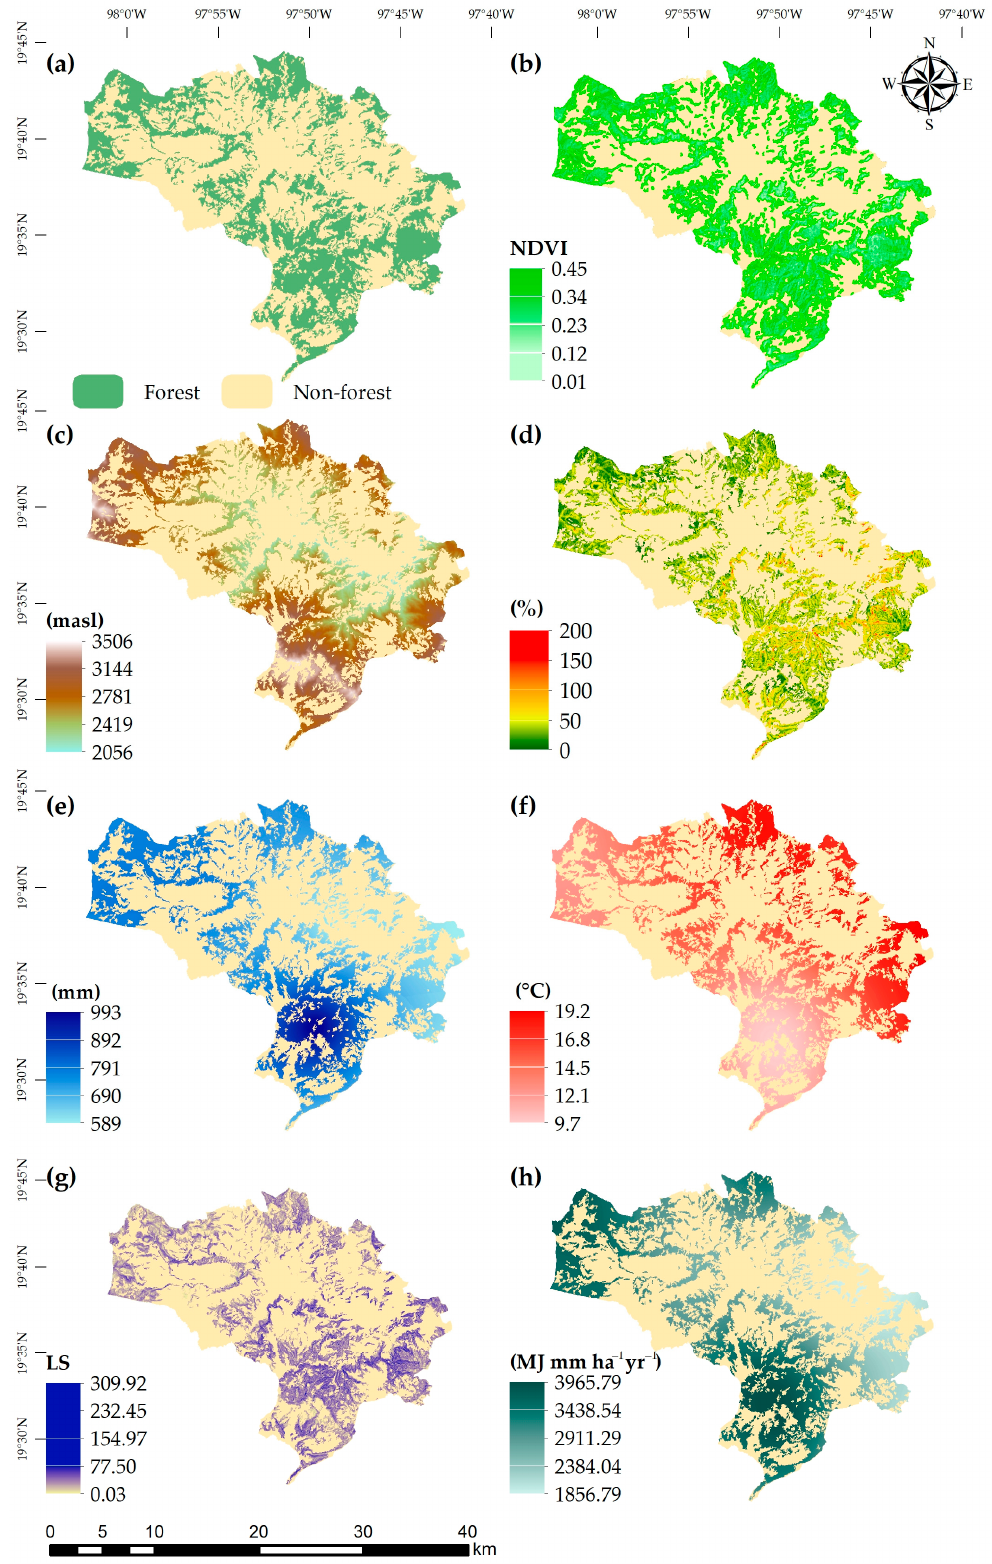
Figure 2. ( a ) Forest/Non-forest cover spatial distribution in Ixtacamaxtitlan, Puebla, México; ( b ) NDVI in forest cover; ( c ) DEM; ( d ) slope; ( e ) precipitation; ( f ) temperature; ( g ) LS-factor; ( h ) R-factor.